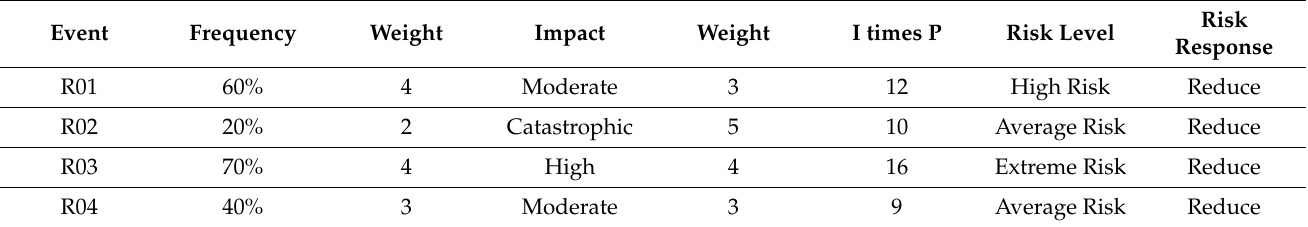
Table 8. Risk Assessment of the Manage ICT Services and Support